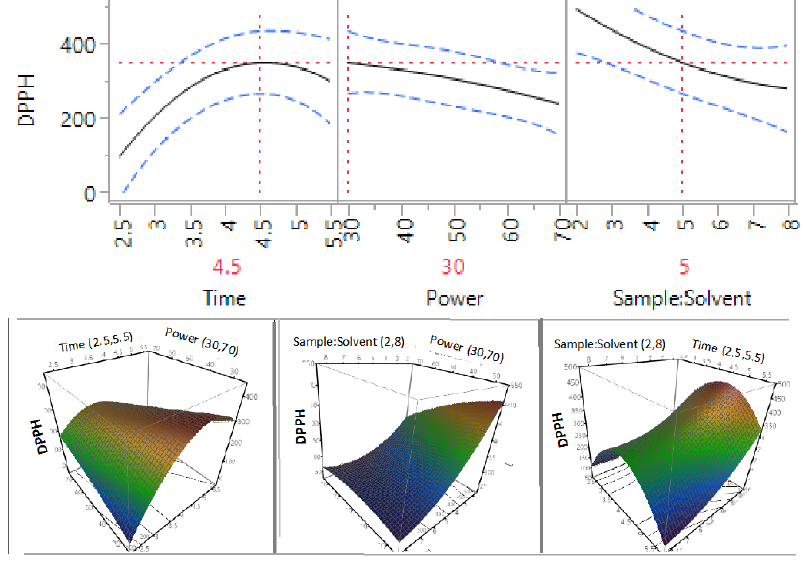
Figure 8. Impact of time (2.5–5.5 min), power (30%–70%, 360–840 W) and sample-to-solvent ratio (2–8 g/100 mL) on DPPH antioxidant capacity (µM TE/g).